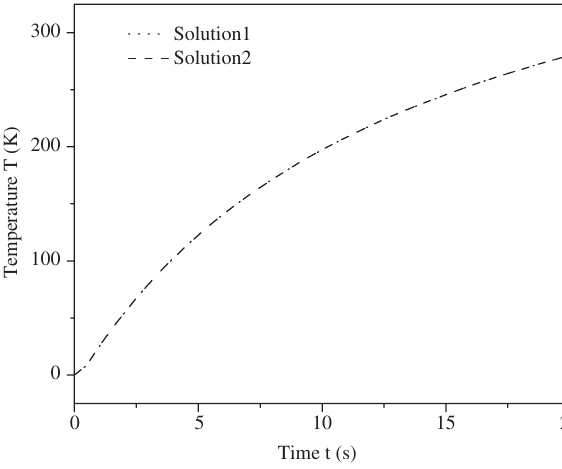
Figure 15 Response histories of temperature in the FGM hollow cylinder at location of (0.25 m, π